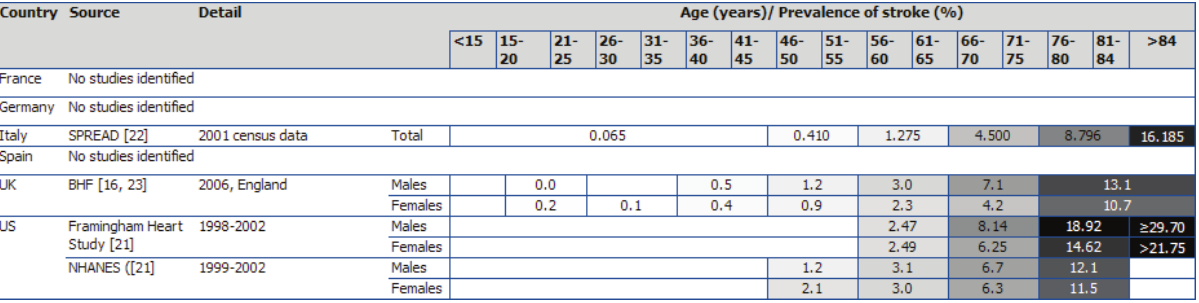
Figure 2: Studies reporting the relationship between the prevalence of stroke and age. Prevalence reported as percentage. Darker shading indicates higher prevalence. BHF: British Heart Foundation, NHANES: National Health and Nutrition Examination Survey, NHLBI: National Heart, Lung, and Blood Institute, SPREAD: Stroke Prevention and Educational Awareness Di ff usion, UK: United Kingdom, US: United States. Sources: [16; 21; 22; 23].